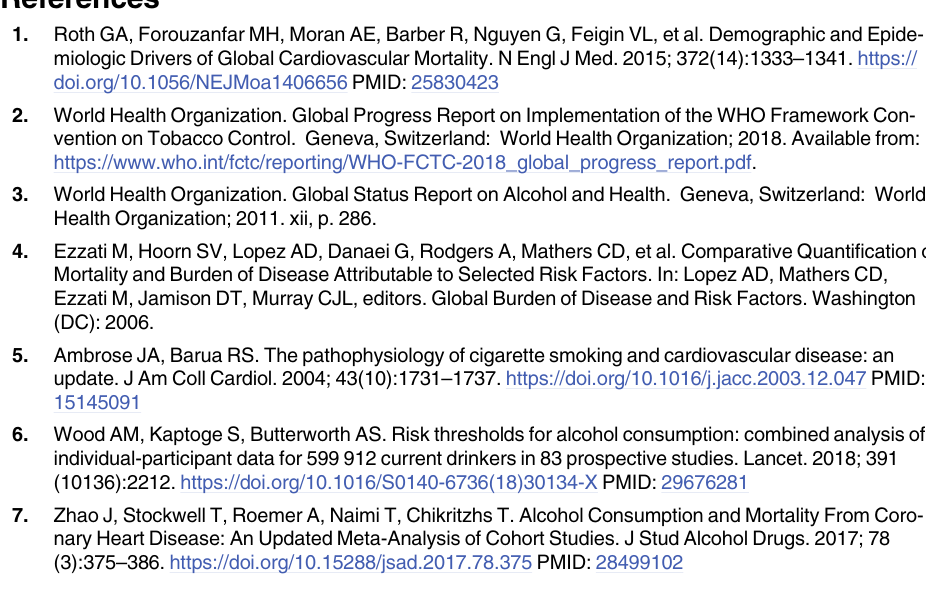
S7 Table. MVMR results of primary alcohol consumption and smoking exposures on Finn- Gen R3 disease